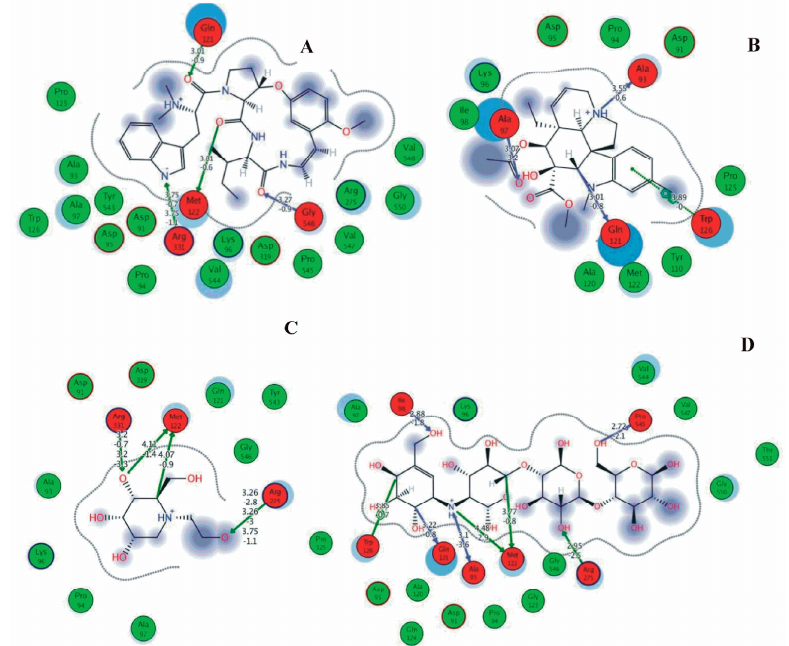
Figure 6. 2D images of the docked conformations of the ligands and standard with the active residues ( A ) 2D image of nummularine-R ( B ) 2D image of Vindoline ( C ) 2D image of miglitol, and ( D ) 2D image of acarbose.